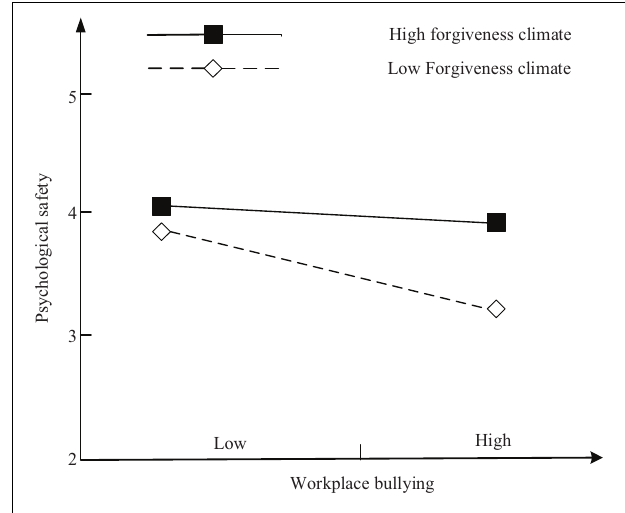
FIGURE 3 | The moderating effect of the forgiveness climate.